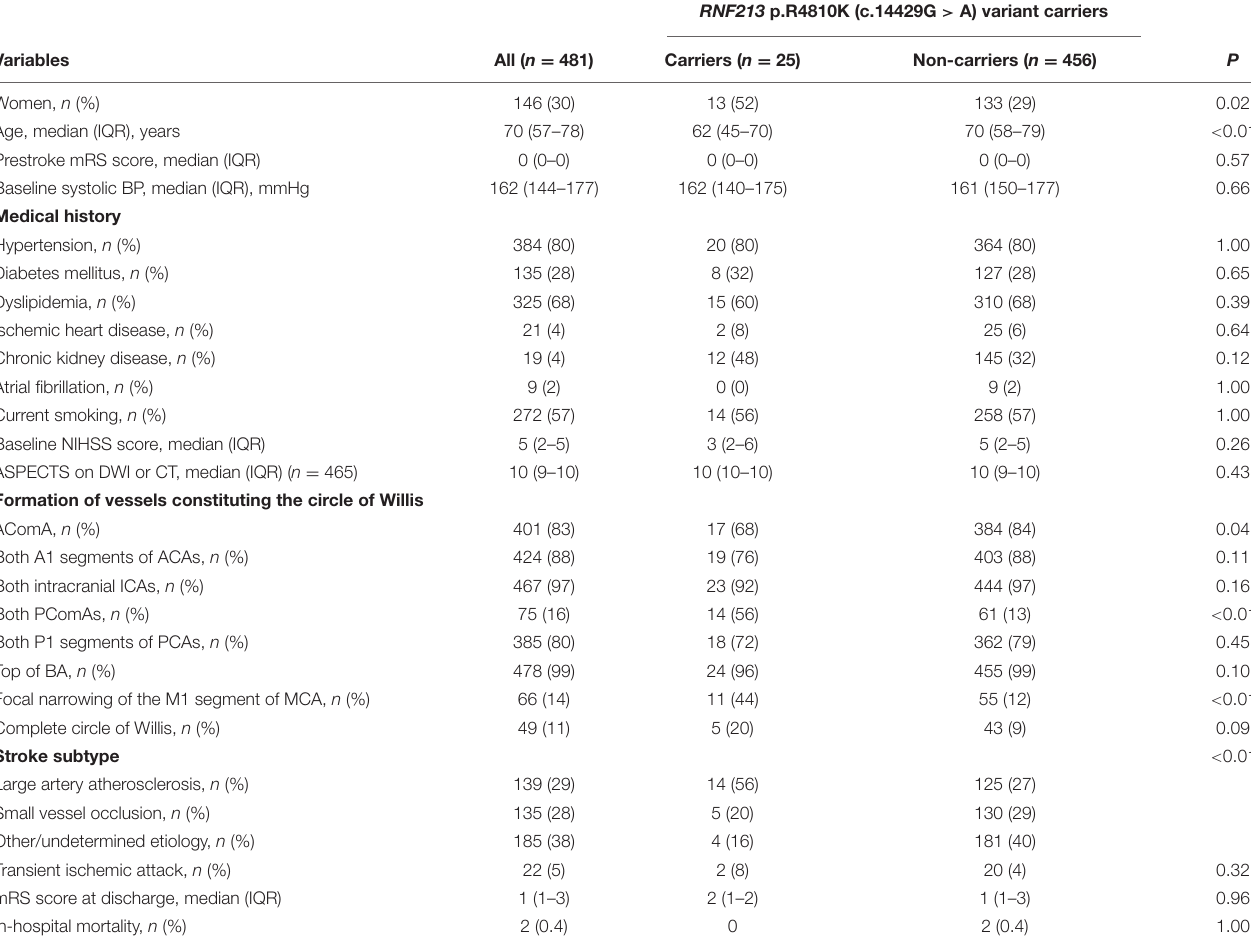
TABLE 1 | Baseline characteristics between RNF213 p.R4810K (c.14429G > A) variant carriers and